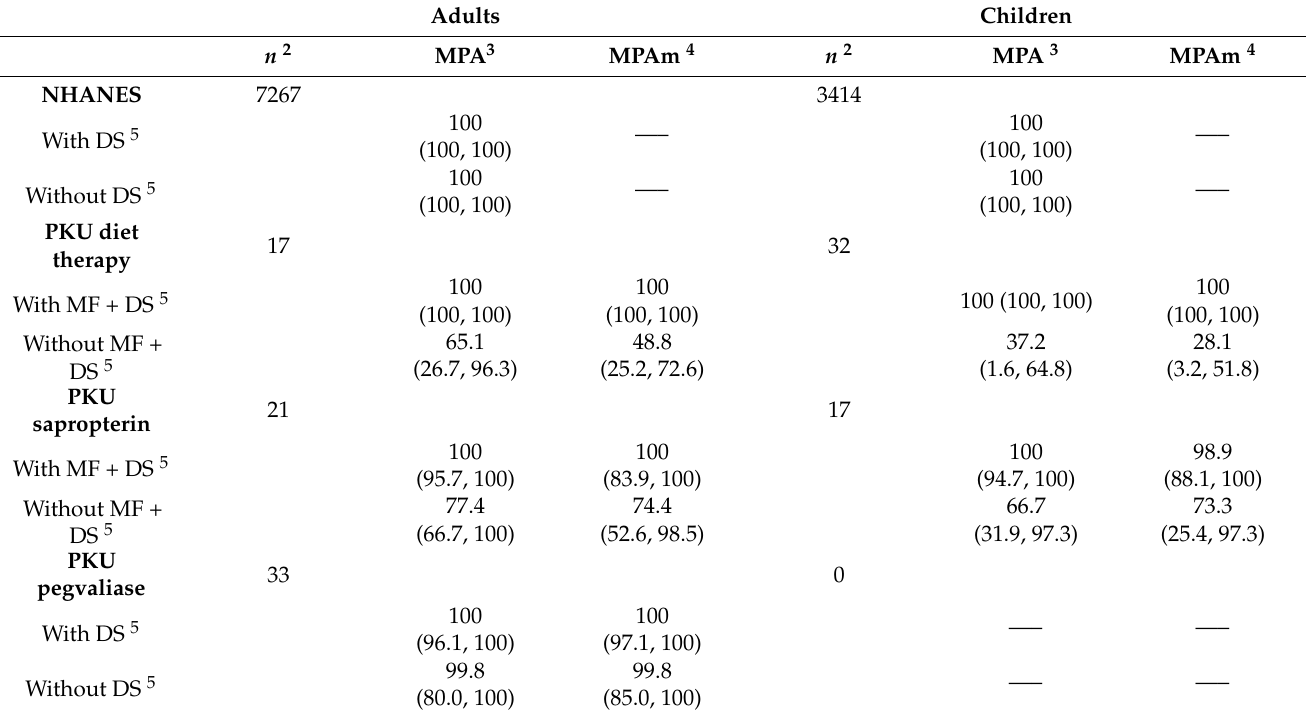
Table 4. Mean Probability of Adequacy (MPA) of nutrients that affect choline metabolism (vitamin B6, vitamin B12, folate, methionine) among individuals with PKU ( n = 120) and NHANES participants ( n = 10,681), by age and treatment group 1